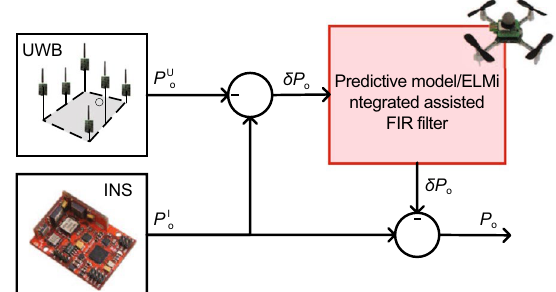
Fig. 1 The scheme of the predictive model/ELM integrated assisted FIR filter for UWB-based quad-rotor aircraft